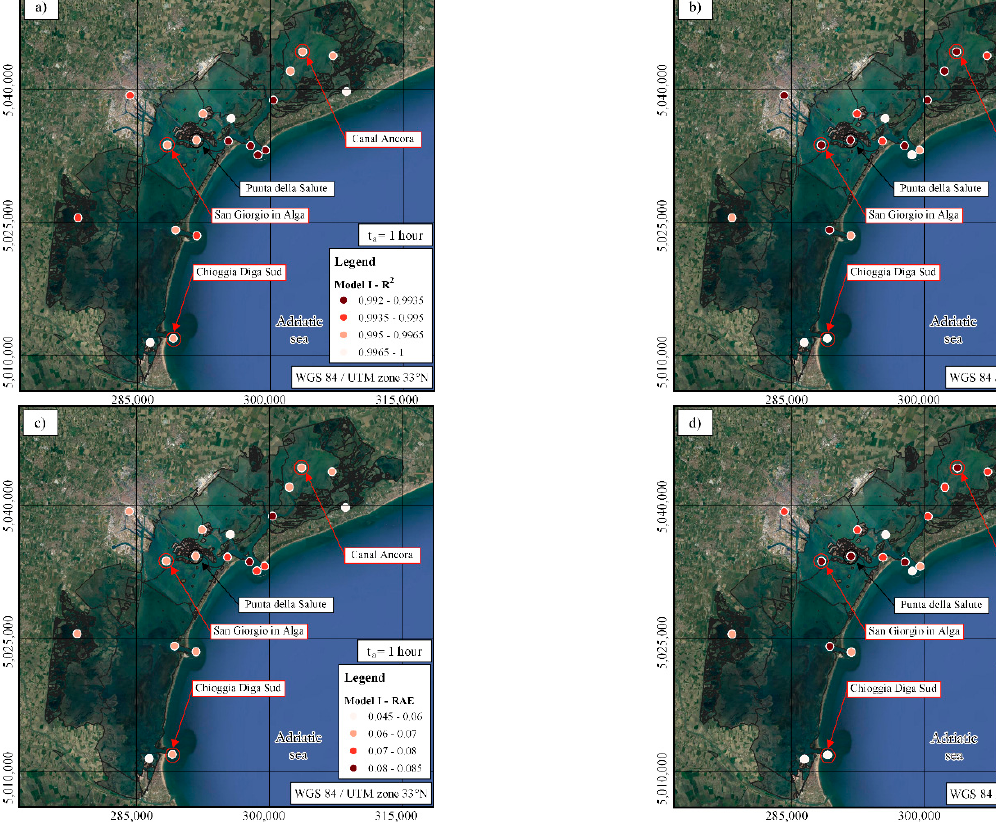
Figure 7. R 2 and RAE scattered maps: Model I— R 2 and t a = 1 h ( a ); Model IV— R 2 and t a = 72 h ( b ); Model I— RAE and t a = 1 h ( c ); Model IV— RAE and t a = 72 h ( d ).